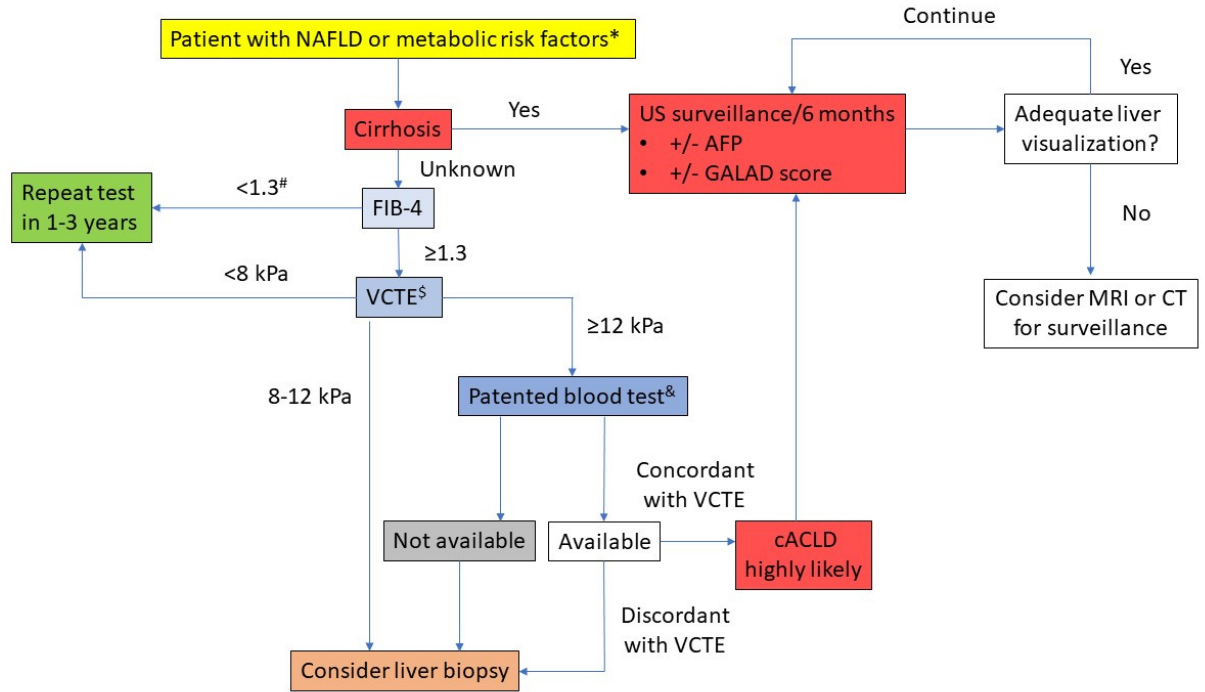
Figure 2. Proposed diagnostic algorithm for stratifying the risk of hepatocellular carcinoma and surveillance in patients with NAFLD. FIB-4—fibrosis-4 index; VCTE—vibration-controlled transient elastography; cACLD—compensated advanced chronic liver disease; AFP—alpha-fetoprotein; MRI—magnetic resonance imaging; CT—computerized tomography. * Presence of type 2 diabetes mellitus or any two of the following: central obesity, elevated triglycerides or low HDL cholesterol, arterial hypertension and insulin resistance. # FIB-4 < 2.0 in patients >65 years. & Other simple and validated non-invasive tests based on routine blood parameters may be used instead. $ Other ultrasound-based elastography methods may be used, but they have less well-defined cut-offs. Cut-offs: Enhanced Liver Fibrosis (ELF™ test) 9.8; Fiobrotest 0.48; FibroMeter 0.45. Adapted based on references [127,128,142–144] .